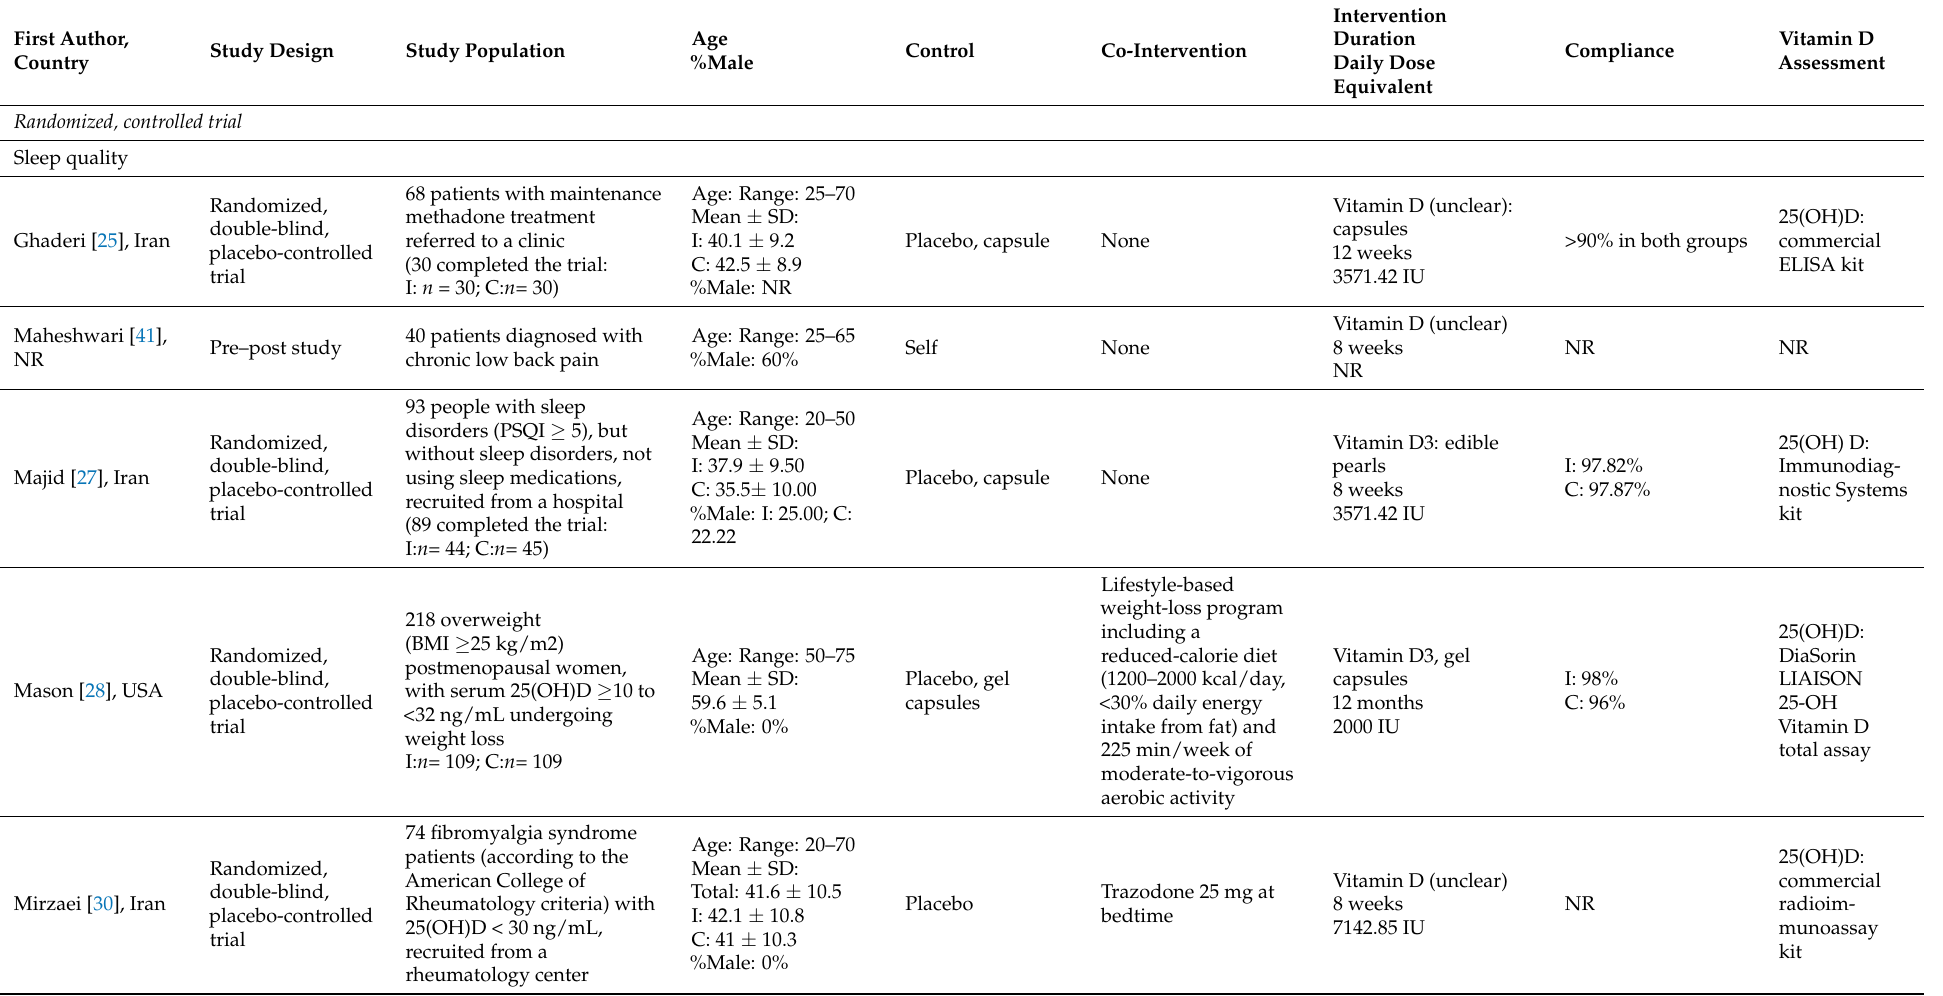
Table 1. Characteristics of included